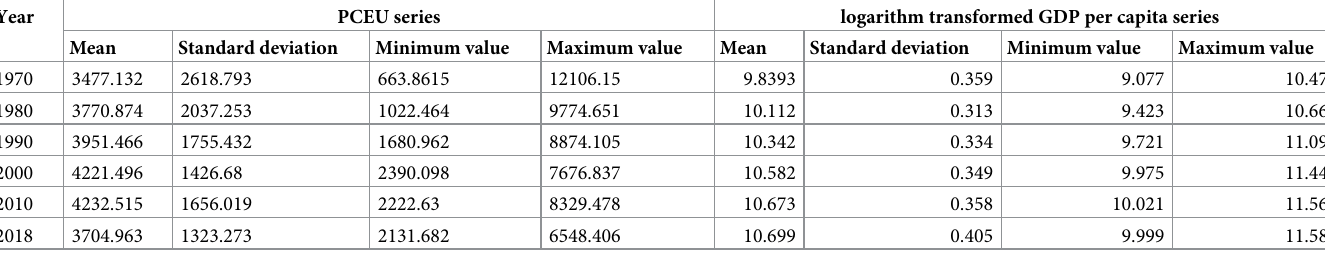
Table 2. Descriptive statistics of PCEU series with and logarithmic-transformed GDP per capita.